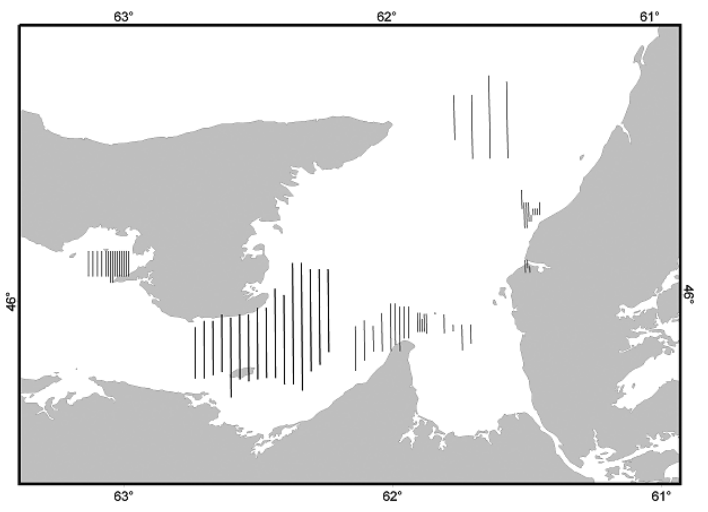
Fig. 5. Aerial survey transects flown in the Gulf of St. Lawrence during Janu - ary-February